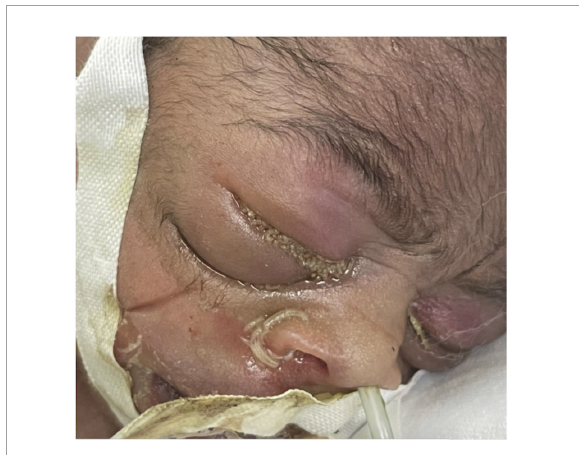
FIGURE1 Insect larvae in the eyes and coming out of the